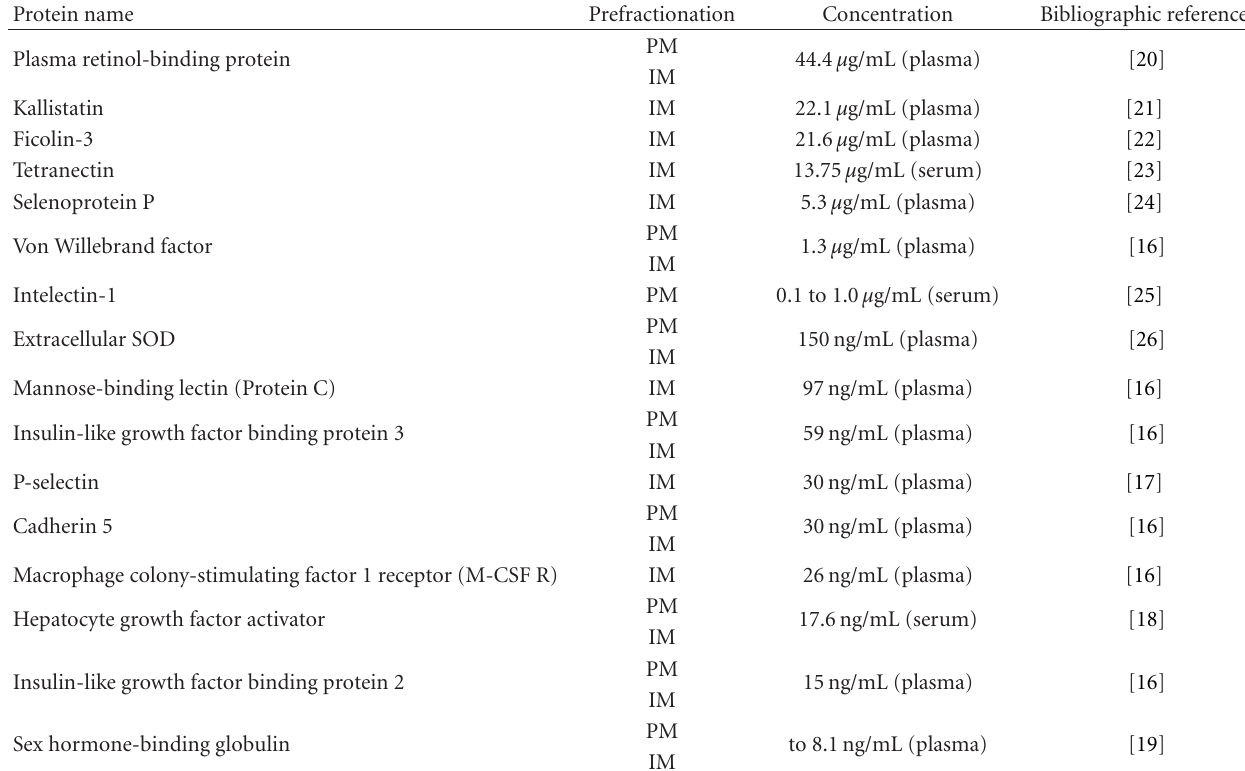
Table 2: Some of the weakly abundant plasma proteins identified with two or more peptides after immunoa ffi nity depletion of high- abundant proteins (IM) or hexapeptide ligand library treatment (PM). Associated concentrations were found in the literature in the mid- range from 5 to 50 000 ng/mL serum or